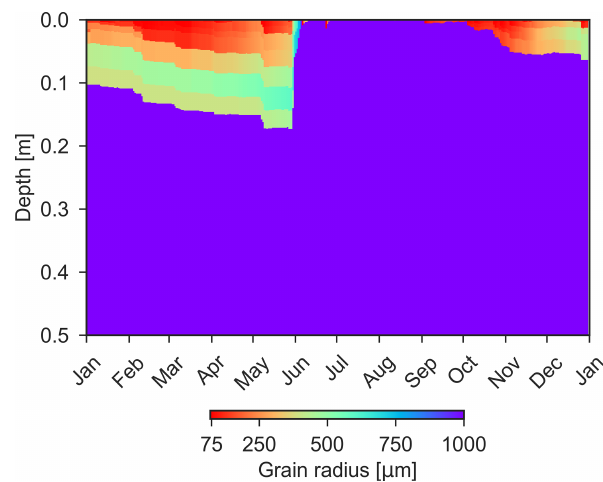
Figure 7. RACMO2.3p3 grain radius of the upper 20 snow layers as a function of depth for 2012, for a grid point within area E (Fig. 6b). Bare ice is indicated by a grain radius of